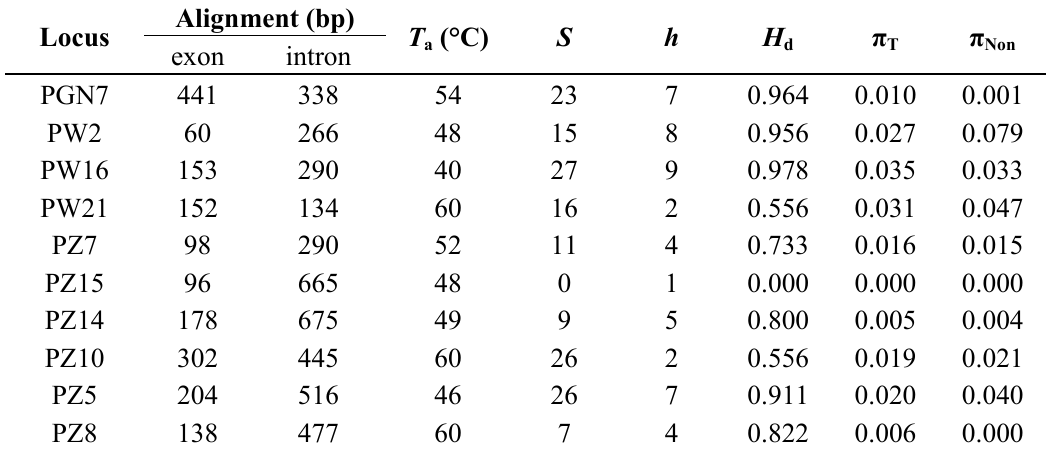
Table 2. Nucleotide diversity of the ten single copy nuclear genes in Panax quinquefolium . Alignment Locus